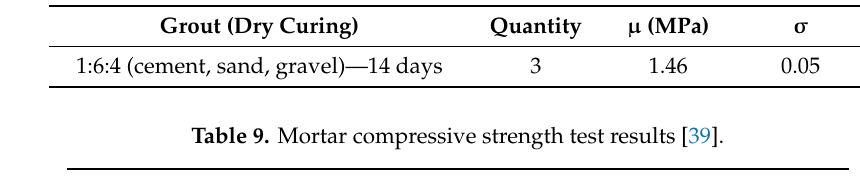
Table 8. Grout compressive strength test results [39].